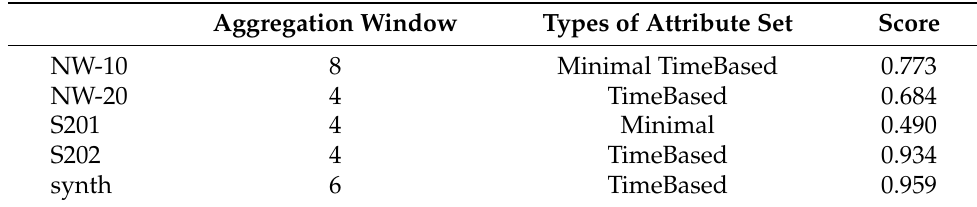
Table 5. Parameter values adopted in obtaining the best Score value by the HDBSCAN method on each of the data sets—illustrated in Figure